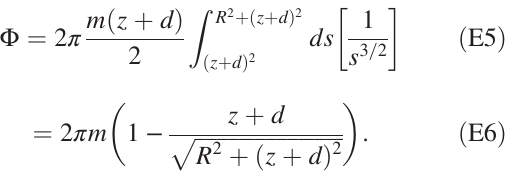
FFT of µ SR raw data FFT of the fit function